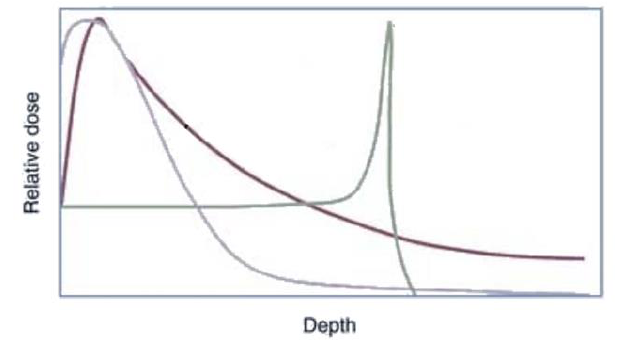
Fig. 2. Relative dose deposition as a function of the interaction depth for photons (red), electrons (blue) and protons (green).